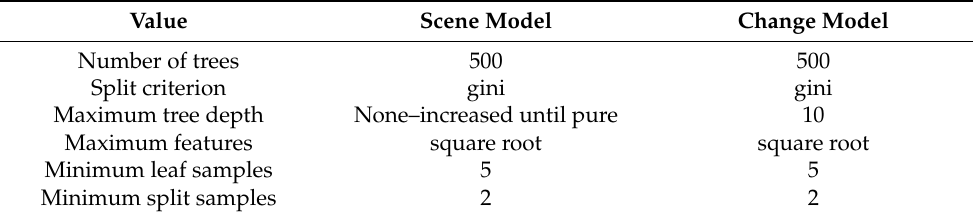
Figure A1. The fine tuning of the RF model. OOB is the error rate for change detection measured for the no. of trees (n_estimators), log2 and square root of the number of features choice for each tree node split. Table A1. The cross-validated grid search results for the hyper-parameters of the scene and change